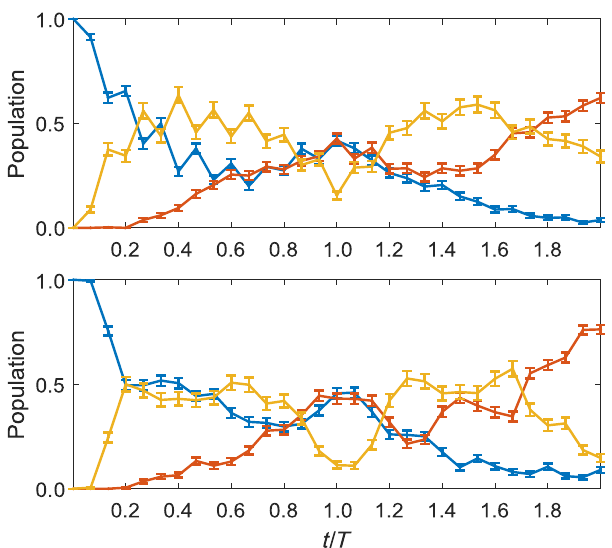
FIG. 6. The populations of the ground state, | 1111 (cid:2) (blue), and of the fully excited state, | 0000 (cid:2) (red), are shown. The system is initialized at t = 0 to the ground state. Ideally, the population of these states at gate time, t = T , is 0.5, implying a maxi-